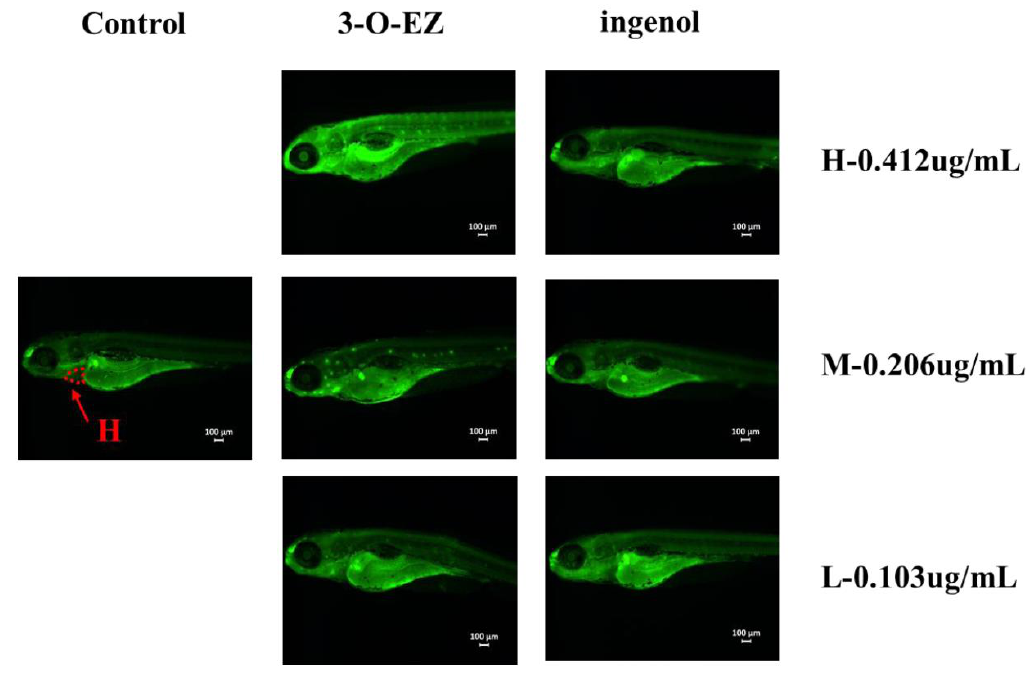
Figure 4. The results of AO staining in zebrafish embryos (heart, H).